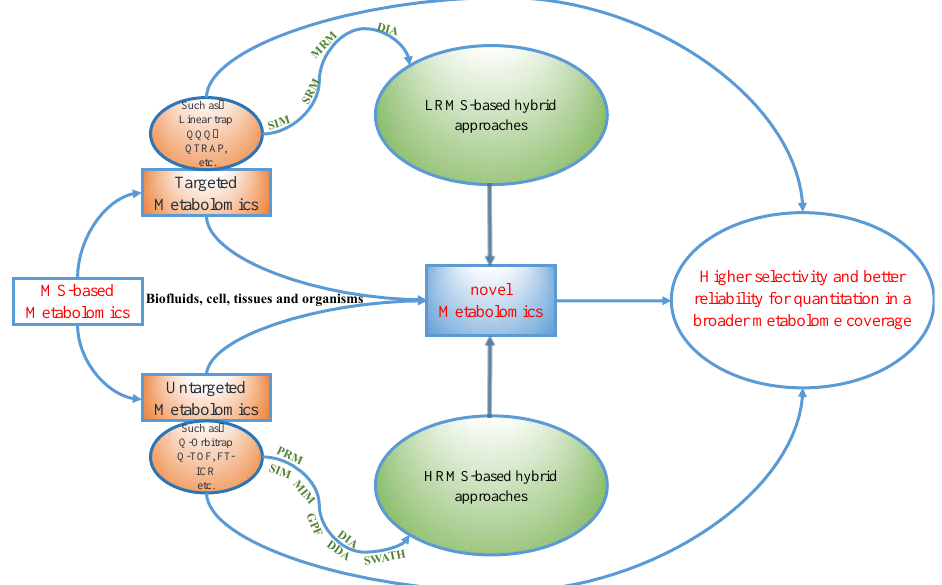
Figure 1. The workflow demonstrates the development process from targeted metabolomics and untargeted metabolomics to novel metabolomics analysis.